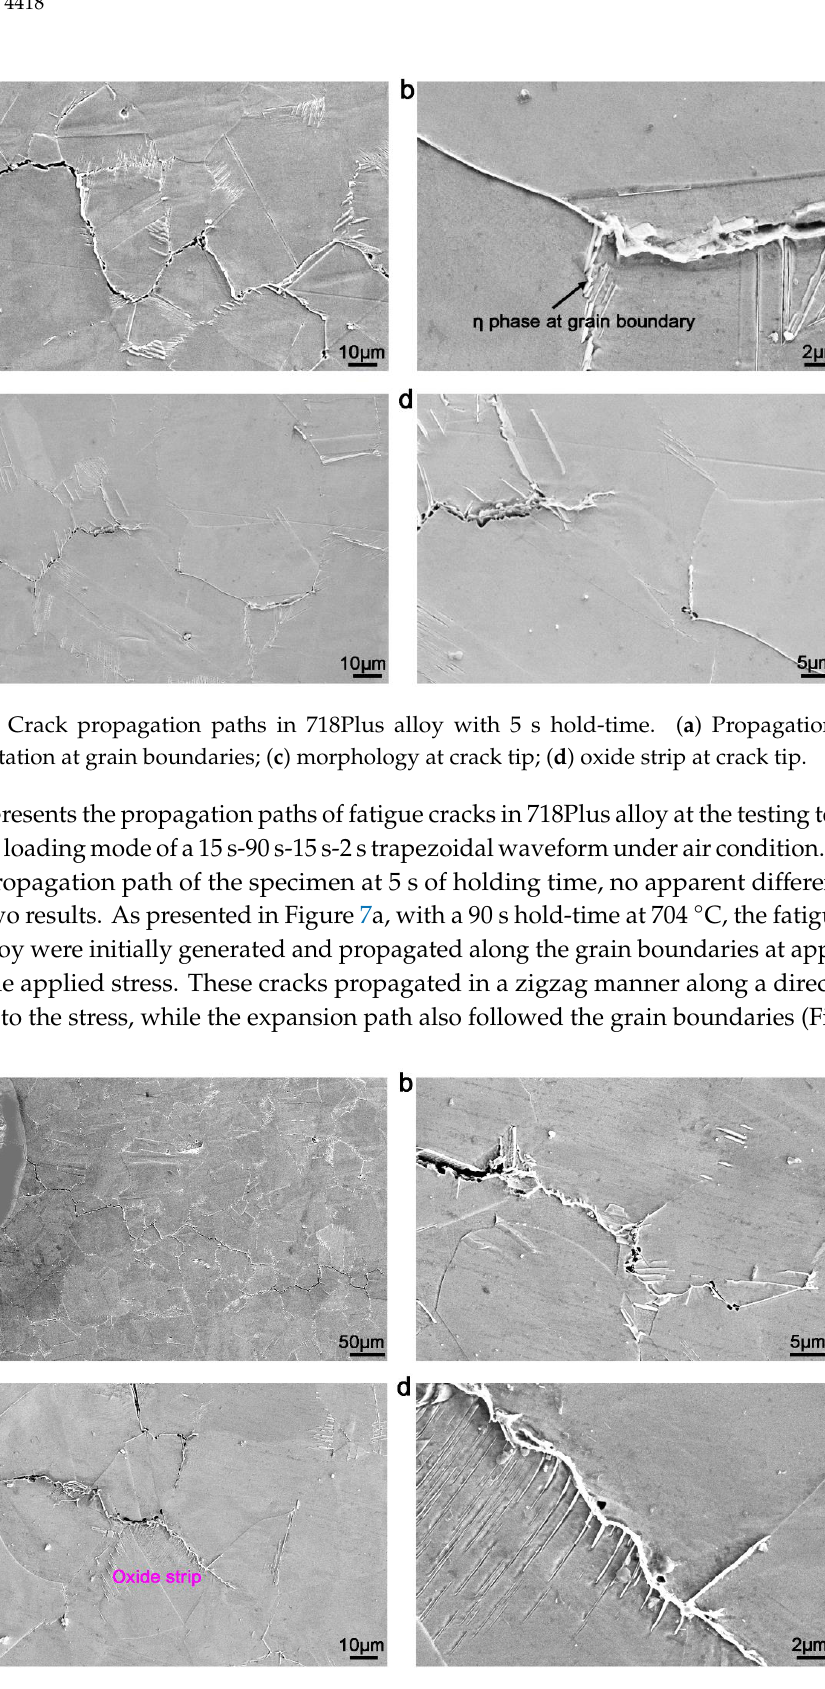
Figure 7. Propagation paths of cracks in 718Plus alloy withhold-time of 90 s. ( a ) Propagation path; ( b ) precipitation at grain boundaries; ( c ) morphology at crack tip; ( d ) oxide strip at crack tip.